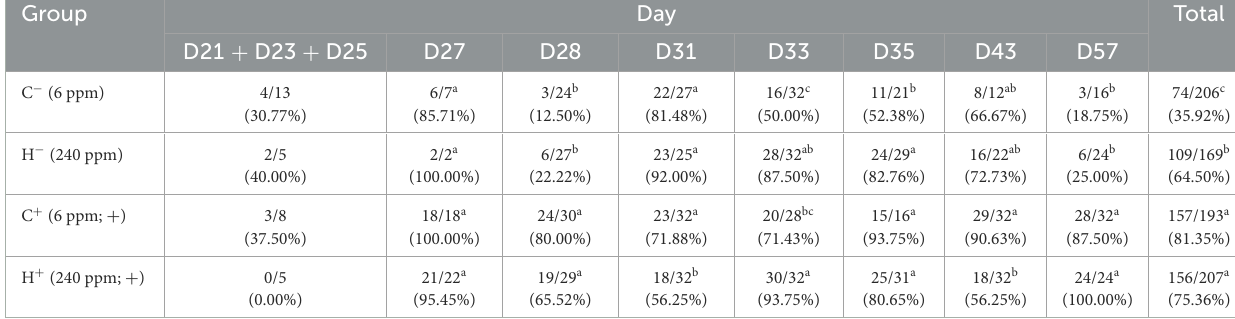
TABLE 5 Numbers and ratios of rats shedding the bla CTX − M − 1 gene, as determined by PCR.